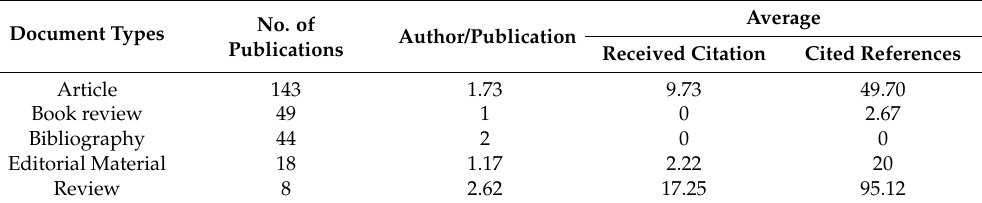
Table 8. Received citations and cited references according to document types.